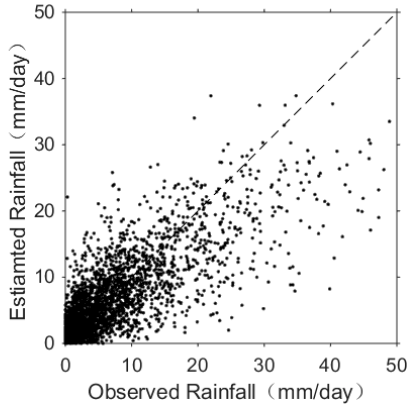
Figure 5. Similar to Figure 4h, but for area mean Figure 6. Similar to Figure 5 (7), but for area mean precipitation.